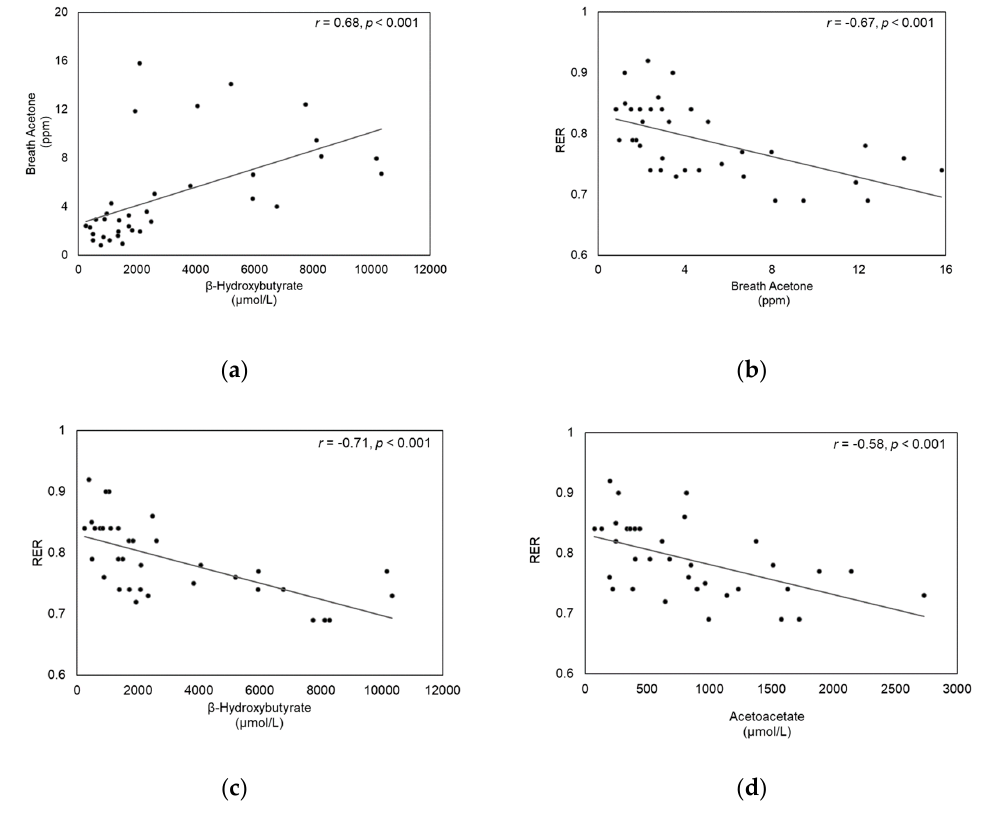
Figure 3. Correlation between ( a ) Breath acetone and β -hydroxybutyrate , ( b ) RER and Breath acetone , ( c ) RER and β -hydroxybutyrate, and ( d ) RER and Acetoacetate.